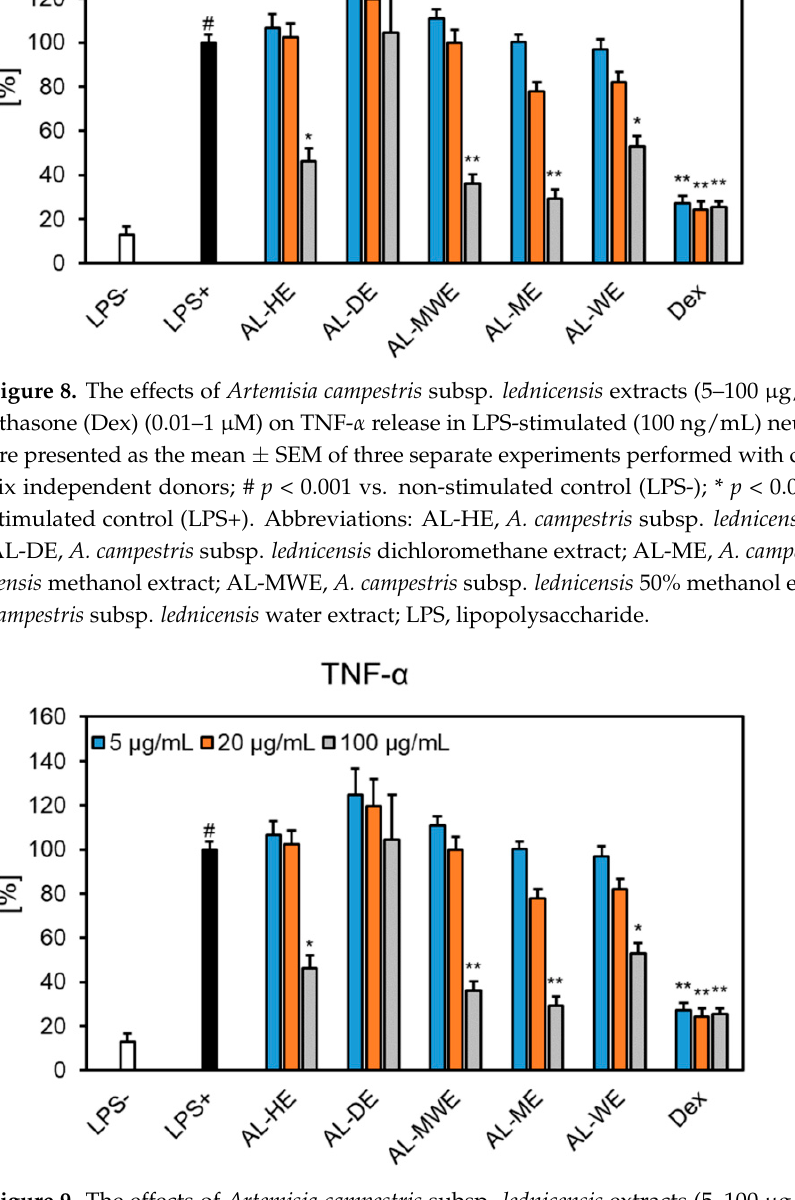
Figure 9. The effects of Artemisia campestris subsp. lednicensis extracts (5–100 μ g/mL) and dexame- thasone (Dex) (0.01–1 μ M) on IL-1 β release in LPS-stimulated (100 ng/mL) neutrophils. Results are presented as the mean ± SEM of three separate experiments performed with cells isolated from six independent donors; # p < 0.001 vs. non-stimulated control (LPS-); * p < 0.05; ** p < 0.001 vs. stimu- lated control (LPS+). Abbreviations: AL-HE, A. campestris subsp. lednicensis hexane extract; AL-DE,